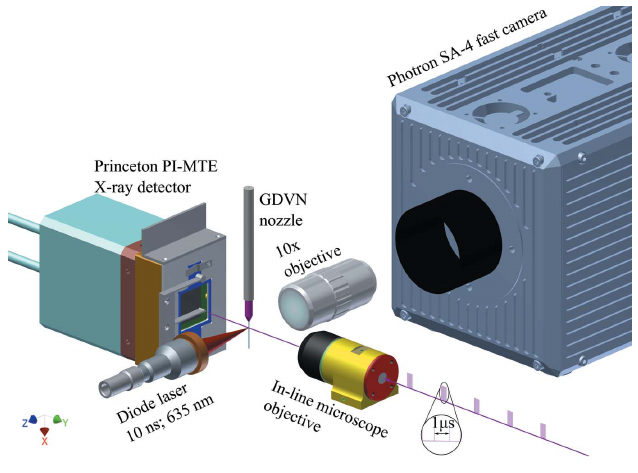
Figure 2 Schematic of the experimental setup in the Bauhaus chamber at FLASH. The X-ray-pulse trains pass through the in-line microscope into the interaction region. The nozzle is positioned so that the emerging jet intercepts the X-rays. The diffraction signal generated by the interaction between the jet and the X-ray beam is recorded by the Princeton PI-MTE detector and the effects of this interaction on the jet are monitored with a bright field microscope setup. Here, pulses from a fiber-coupled diode laser (DILAS) illuminate the jet and the image is formed with an in- vacuum microscope objective and a fast camera (Photron SA-4) located outside the vacuum